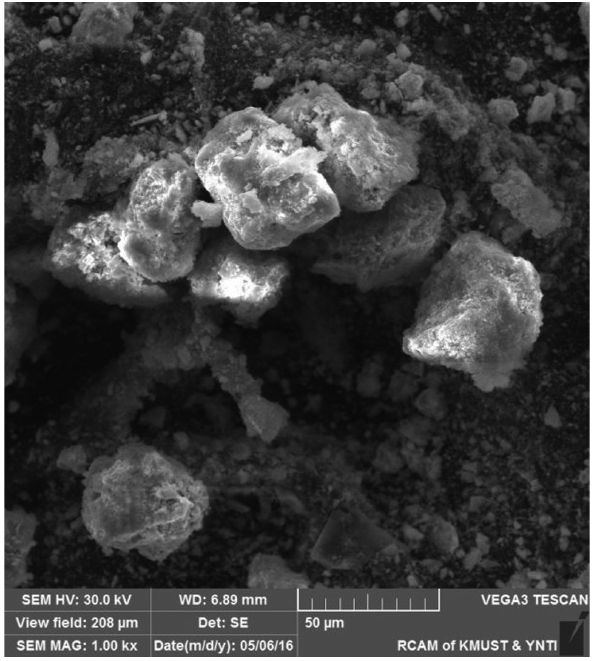
Figure 5: The SEM image of raw materials. speculated that Ge is encapsulated and embedded in the skeleton. The primary purpose of conventional oxidation roasting is to oxidation Ge 2+ and As 3+, which will seriously affect the recycling of germanium and distillation equipment safety at low prices [19]. Besides that,